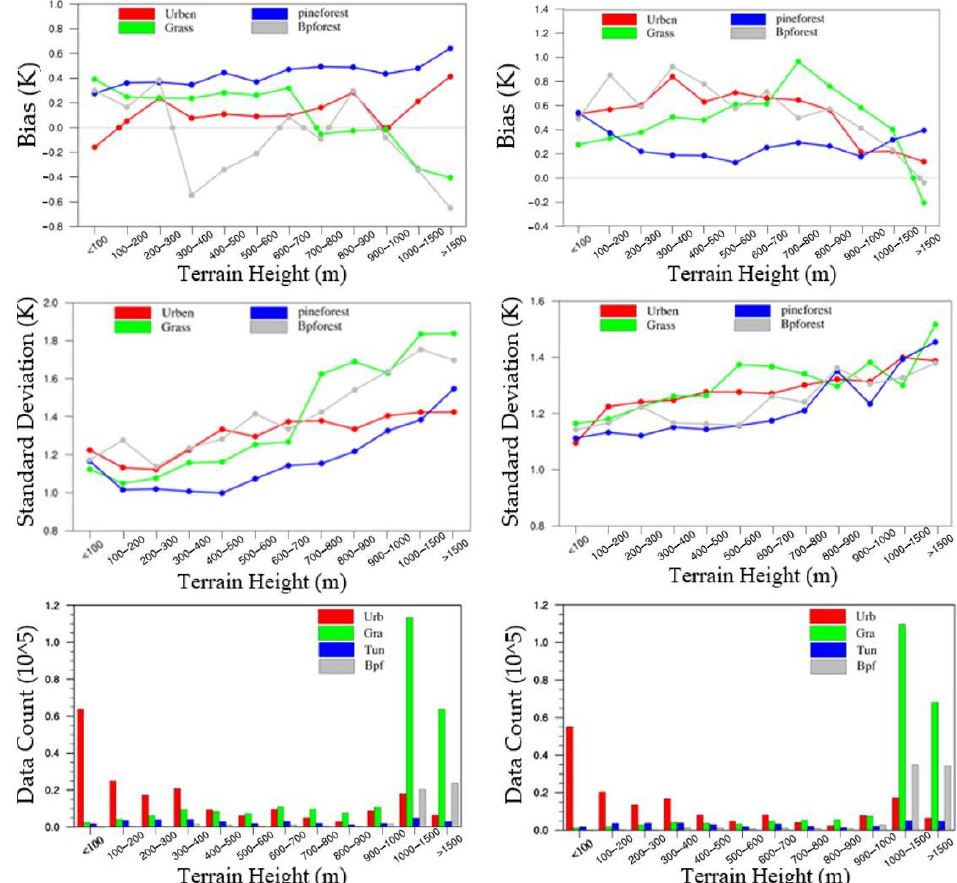
Figure 9. O-B bias (above column curve) and standard deviation (middle column curve) values were obtained for four vegetation types: (urban (red), grasslands (green), pine forests (blue) and broadleaf forests (grey)) on channel 12 ( left ) and channel 14 ( right ) of the AGRI and the changes in the numbers of these four vegetation types (columns) identified at different heights (below). Data counts are shown by bars with corresponding colors.